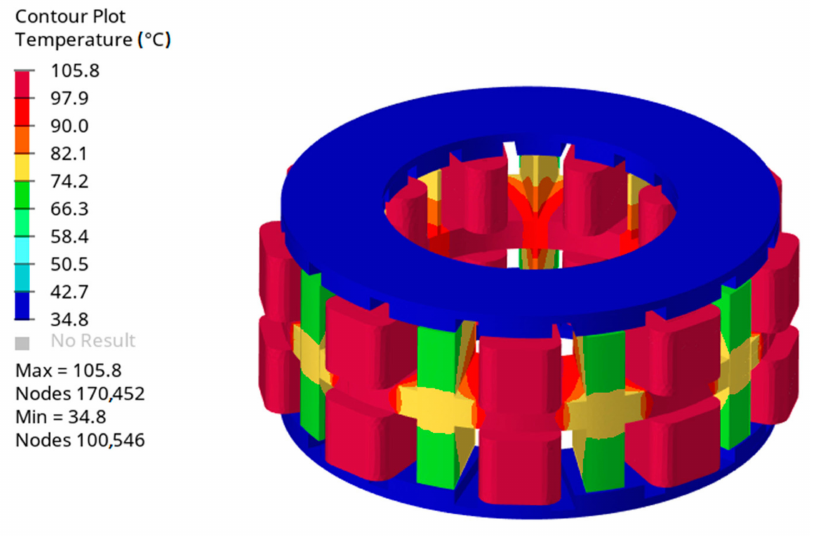
Figure 21. The temperature distribution in the active materials of the AFPM motor.